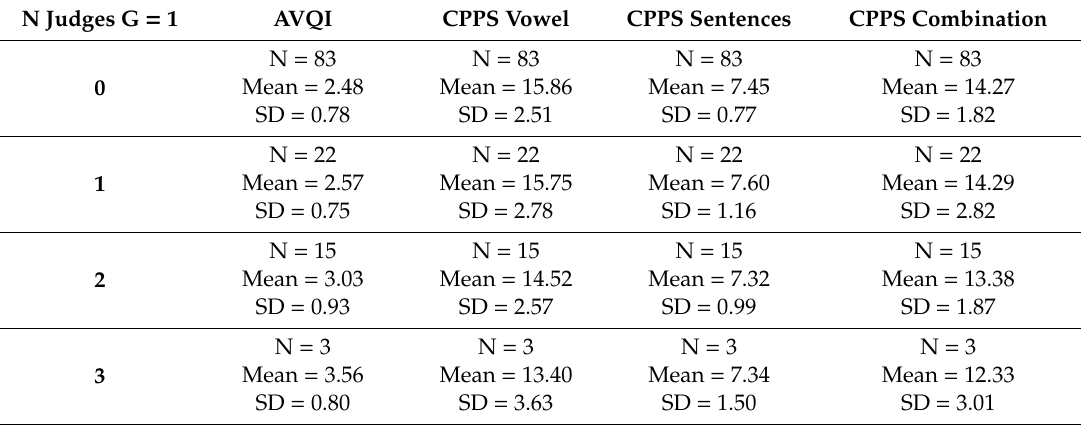
Table 5. Di ff erences in AVQI and CPPS between subclinical levels of